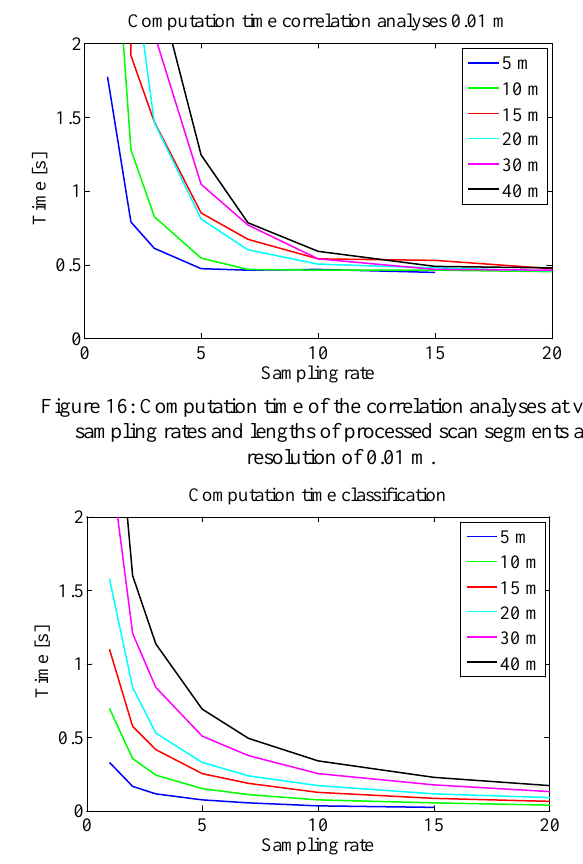
Figure 15: Completeness at various sampling rates and lengths of processed scan segments.